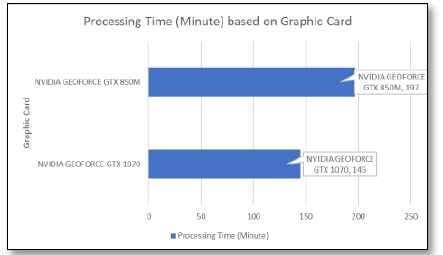
Figure 10: Comparison between processing time based on graphic card.